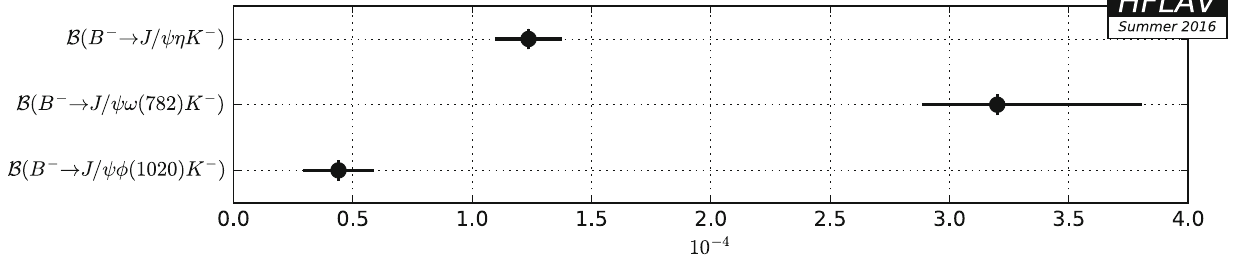
Fig. 129 Summary of the averages from Table